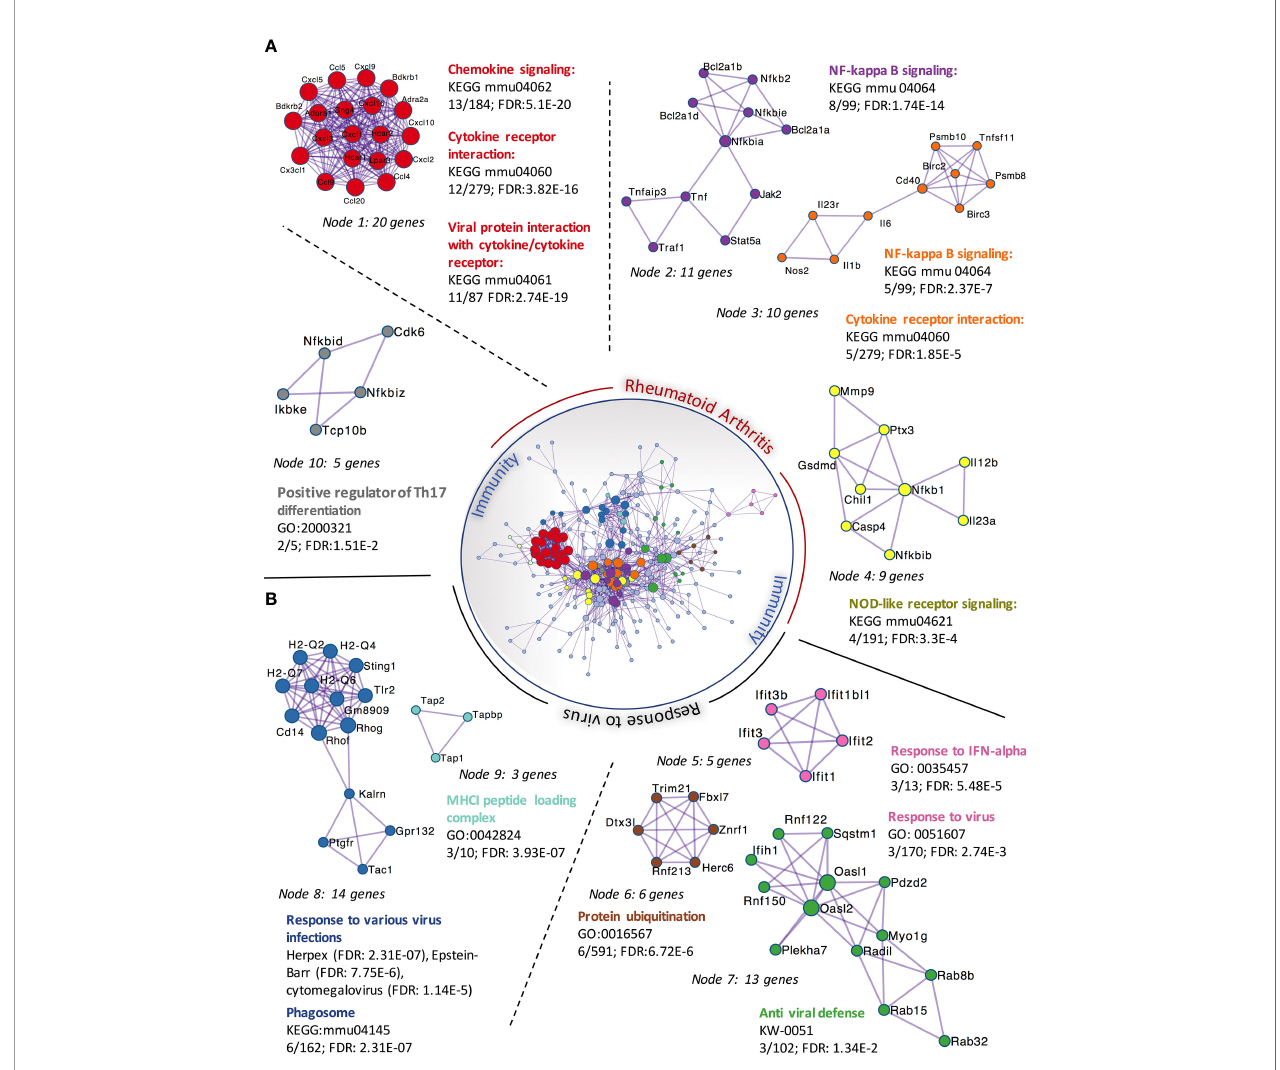
FIGURE 4 | Protein-protein interaction networks of upregulated DEGs in C. perfringens sialidase treated SFs. Upregulated DEGs identi fi ed in Figure 3 were used to perform protein-protein interaction enrichment in Metascape (https://metascape.org/ ). Genes are represented by coloured circles, size is directly proportional to the number of genes in each node. DEGs genes clustered a total of 10 independent nodes based on known protein-protein interactions. Functional pathways signi fi cantly represented in each node are shown. Nodes are classi fi ed into two main categories based on the functional roles: ‘ rheumatoid arthritis ’ (A) and ‘ response to virus ’ (B)